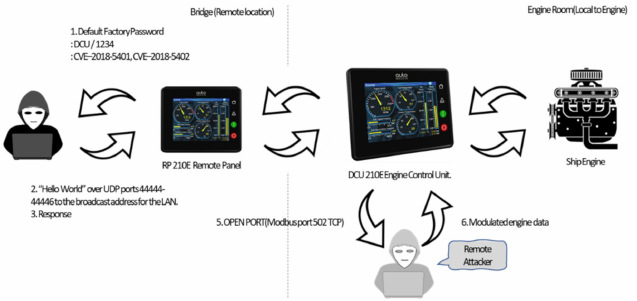
Figure 6. Attack scenario using